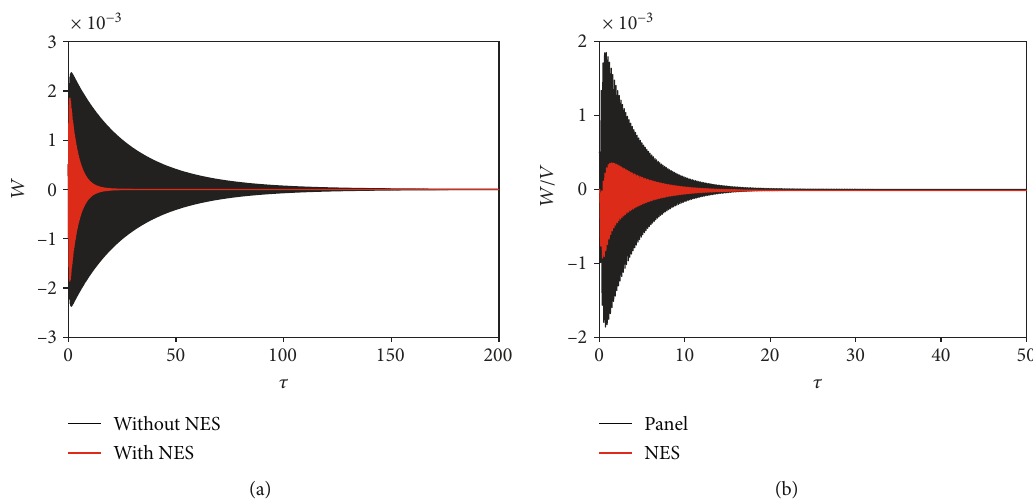
Figure 4: Time history at λ = 346 : 8 : (a) responses of the panel with and without an NES; (b) responses of the NES and panel.